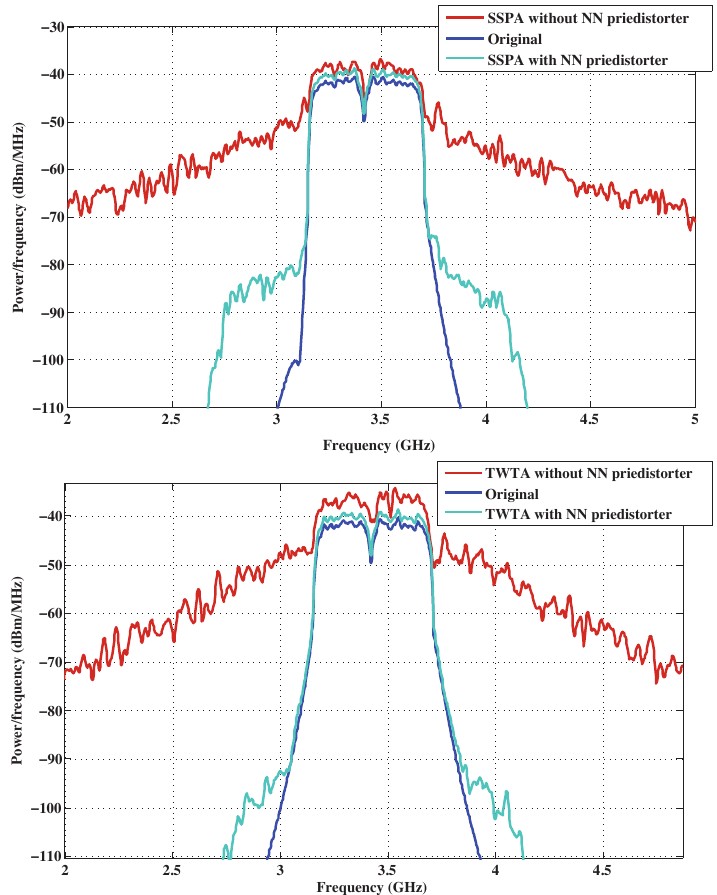
Figure 18. Power Spectral Density: without NN pre-distorter and with implemented NN pre-distorter on Xilinx for both TWTA and